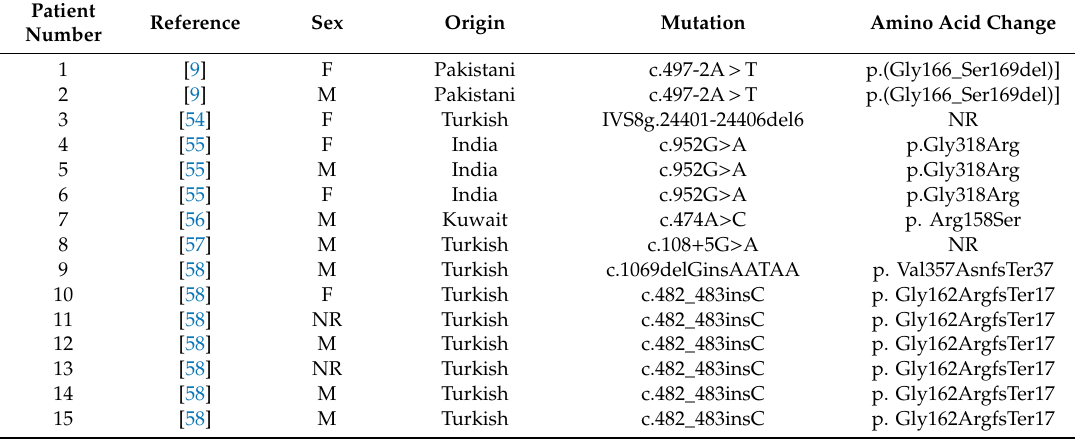
Table 1. Fanconi–Bickel Syndrome (FBS) cases reported from 1987 to